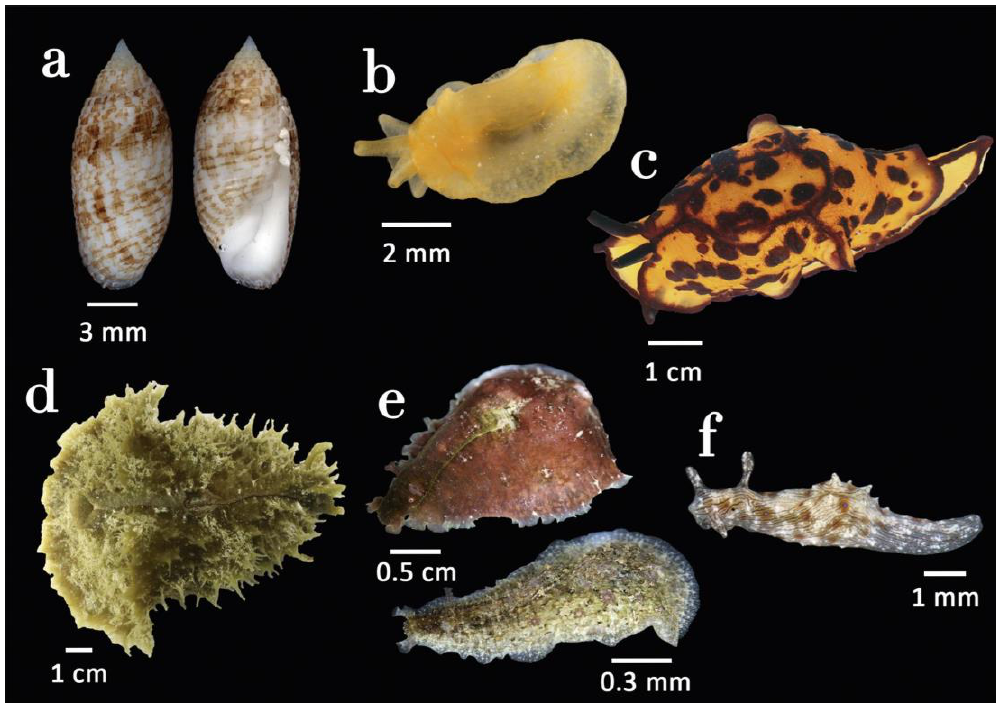
Figure 3. Acteonoidea: ( a ) Pupa tessellata (MCZ:Mala:393822), dorsal and ventral view; Pleurobranchida: ( b ) Berthellina delicata (MCZ:Mala:393775); ( c ) Berthella martensi (MCZ:Mala:393762); Aplysiida: ( d ) Dolabella auricularia (MCZ:Mala:393823); ( e ) Dolabrifera dolabrifera (MCZ:Mala:393776), two color morphotypes; ( f ) Stylocheilus striatus (MCZ:Mala:393764). Photos by T. J. Cunha.